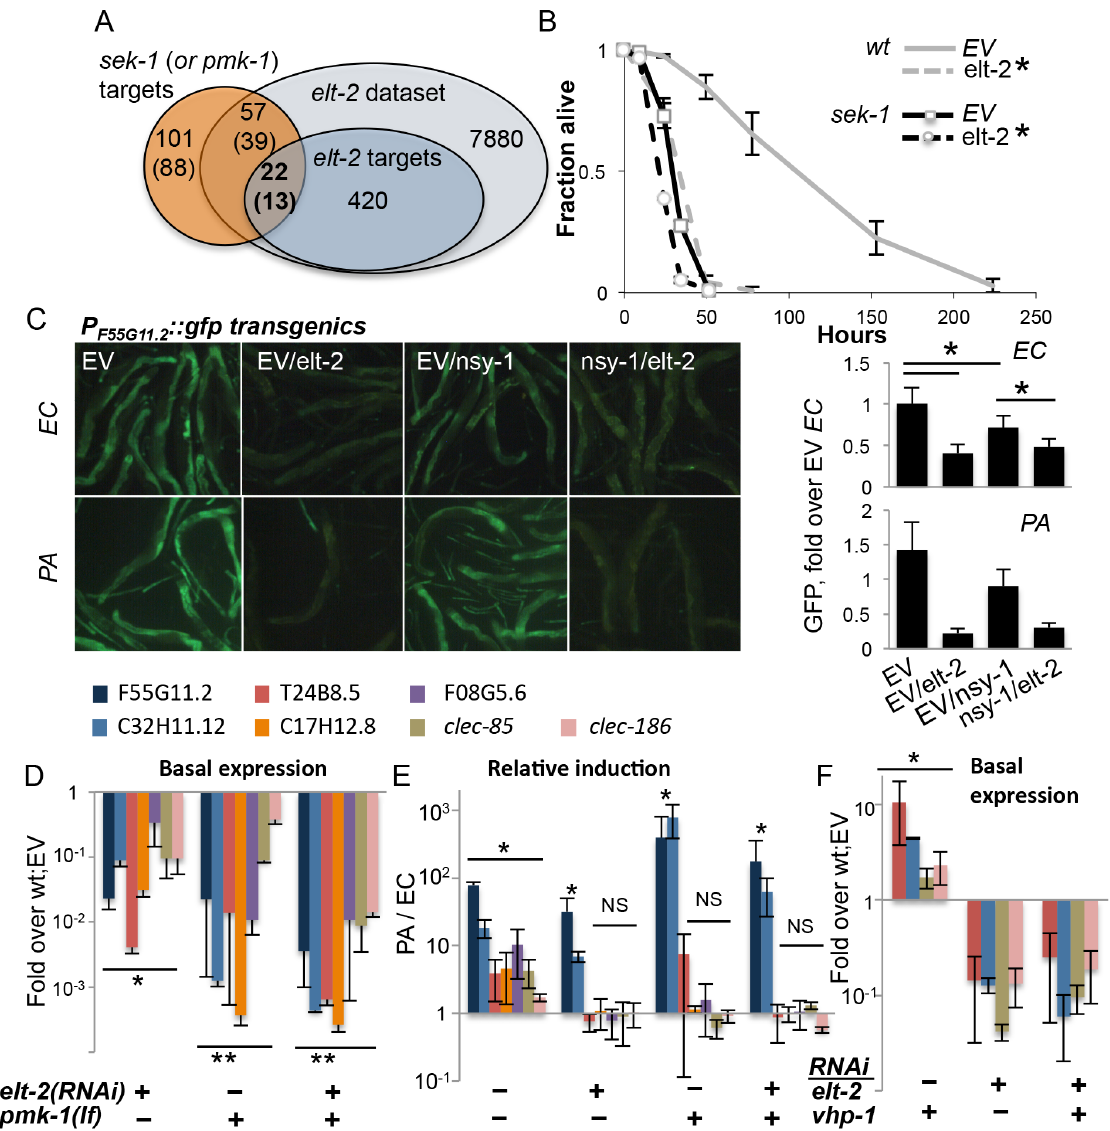
Fig 2. elt-2 and the p38 pathway co-regulate immune protection. A . Overlaps between sek-1 (or pmk-1) targets (Troemel et al ., 2006), and elt-2 targets; gene numbers are shown. B , Survival curves for wildtype and sek-1 animals fed with designated RNAi ’ s during early adulthood, followed by P . aeruginosa infection; averages ± SDs for three plates (N = 92 – 151 per group, * p < 0.0001 (Logrank test)); shown is a representative of several experiments with similar results. C , P F55G11 . 2 :: gfp worms fed with RNAi as designated during adulthood and exposed to P . aeruginosa (PA, 4 hours, N = 10 – 19 per group) or E . coli (EC, N = 19 – 25); signal quantification shown on the right, * p < 3xE-6, ttest. Shown is a representative experiment of two with similar results. D-F , Gene expression in wildtype or pmk-1(km25) loss-of-function animals fed with designated RNAi ’ s during larval development. Shown are averages and SDs for two independent experiments D , F , basal expression (values and statistics relative to values in wt;EV (set to 1 and therefore not shown). E , Induction following 12 hours of P . aeruginosa infection, relative to basal expression in similarly-treated worms grown on E . coli . * p < 0.01, ** p < 0.0005 (paired t-test); asterisks mark significant differences for individual gene(s), or for each of the genes in a group designated by a